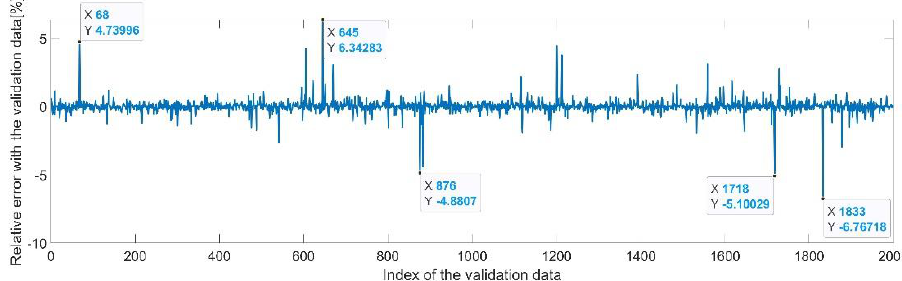
Figure 16. The comparison between the real data (the real value of 𝑞 3 ) and the predicted data (the predicted value of 𝑞 3 ).